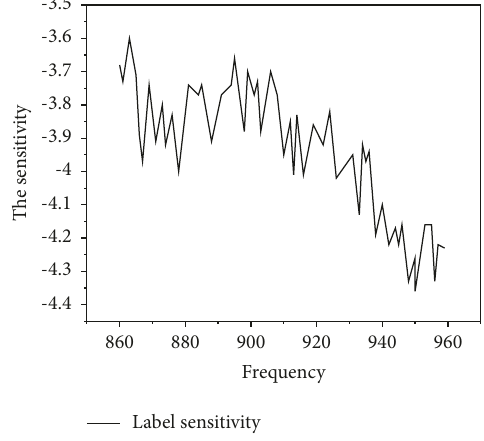
Figure 3: Label sensitivity curve.